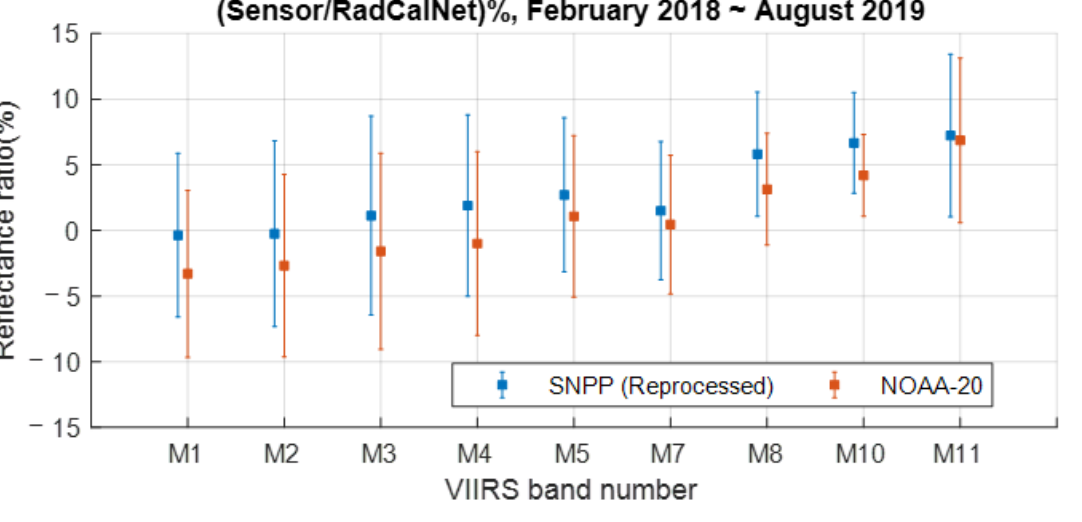
Figure 9. The average reflectance ratio percentage between RadCalNet with reprocessed SNPP/VIIRS and NOAA-20/VIIRS at RVUS from February 2018 to August 2019.